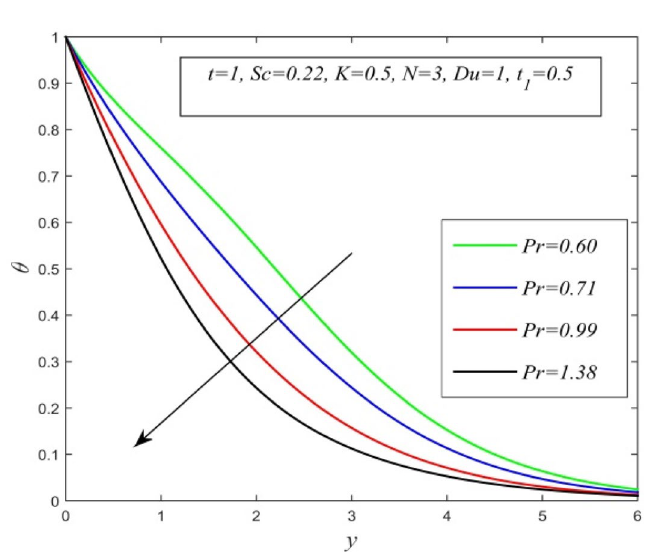
Figure 10. θ versus y for different Pr and t = 1, Sc = 0.22, K = 0.5, N = 3, Du = 1, t 1 =